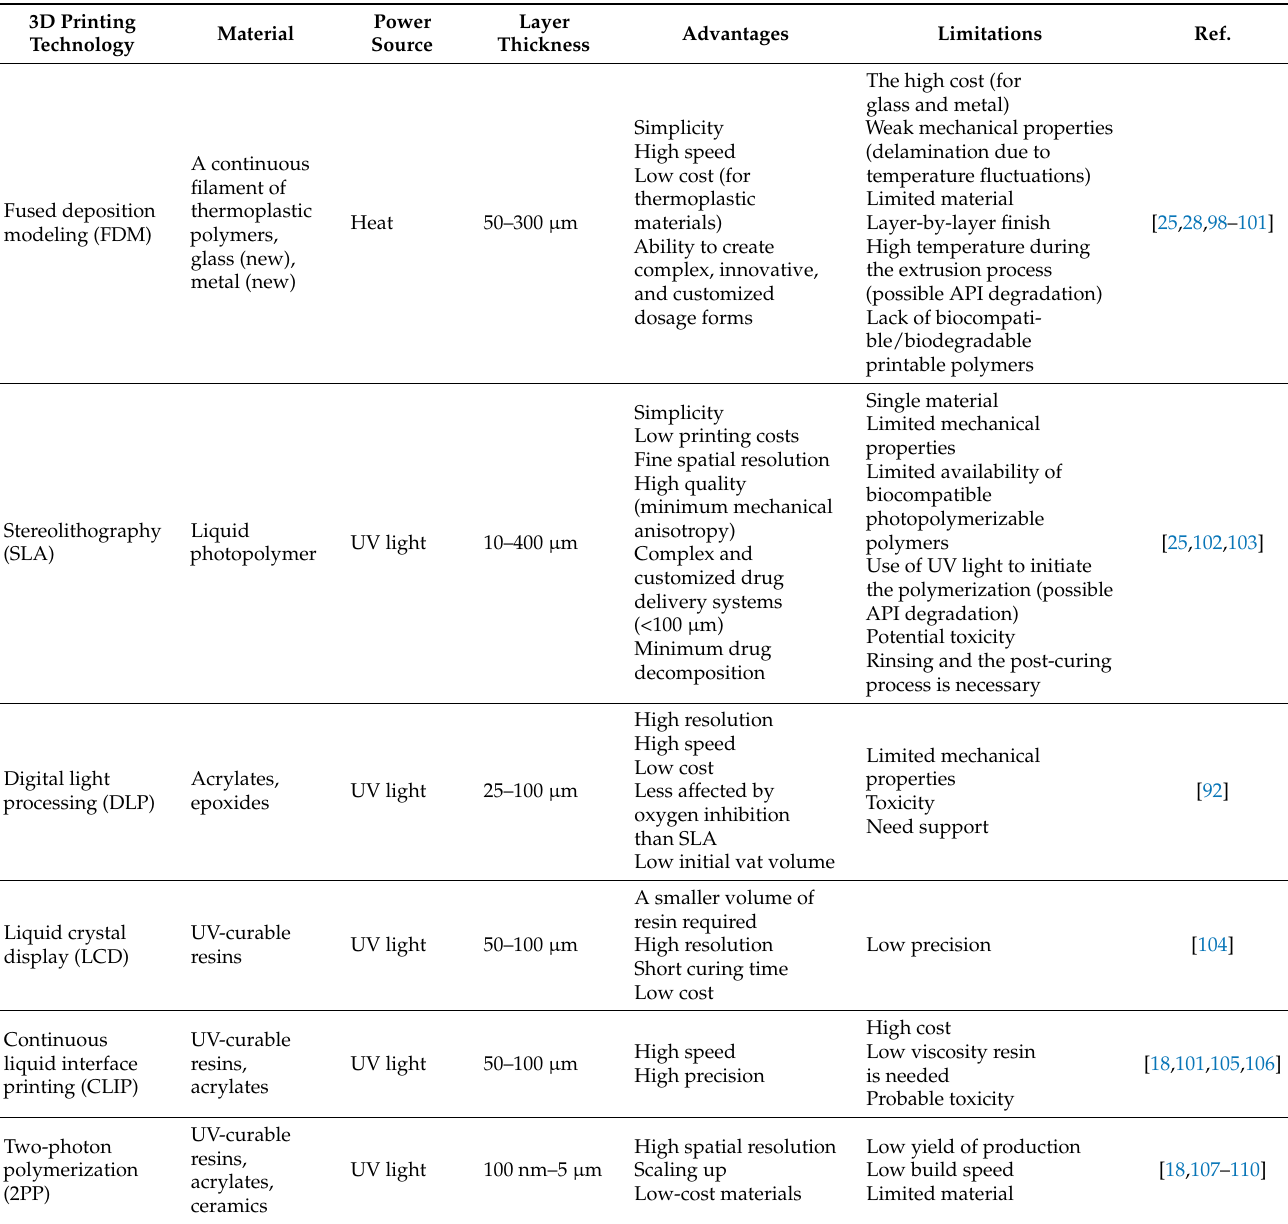
Table 1. A summary of materials, advantages, and limitations of the main methods of 3D printing for micronee- dle